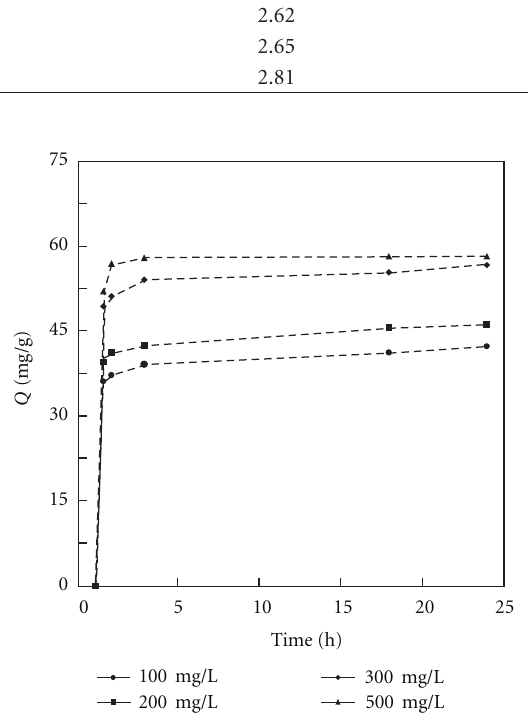
Figure 1: Dynamics of phenol uptake by BK for various initial phenol